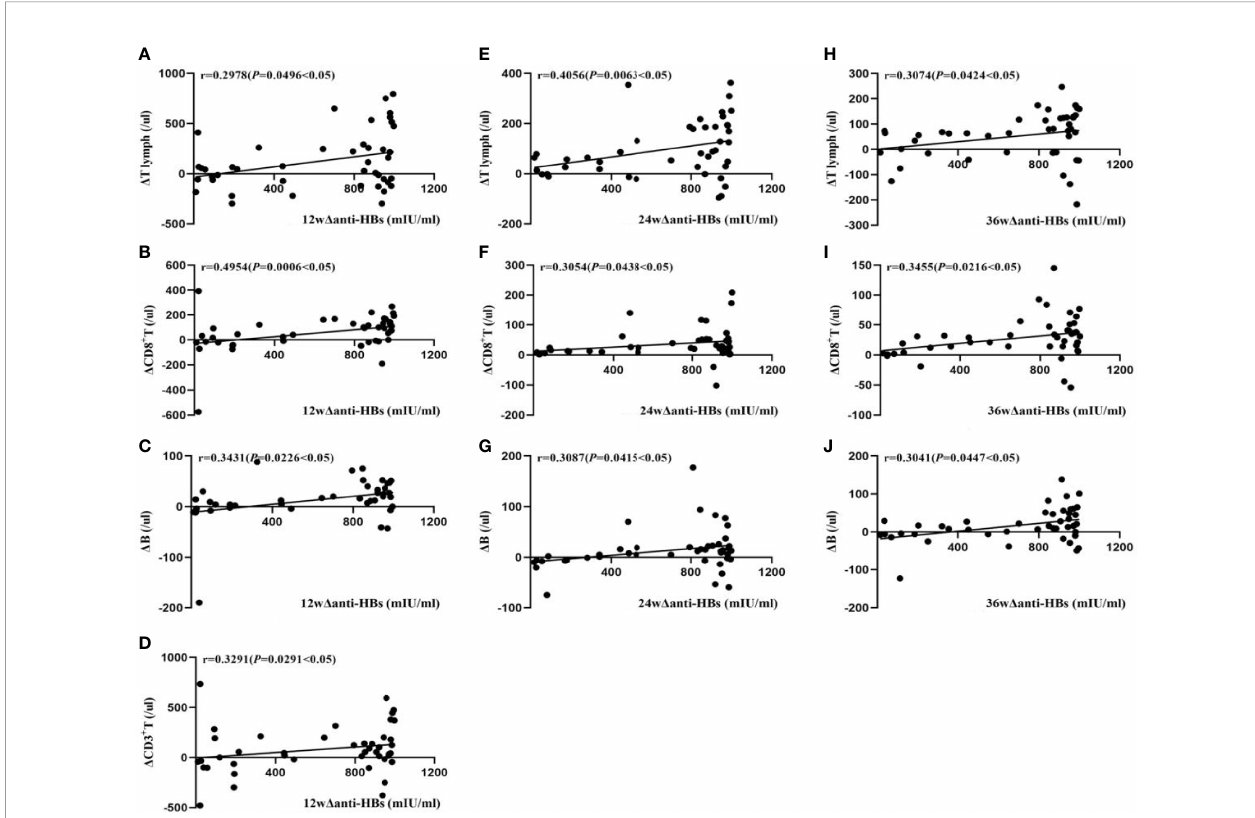
FIGURE 1 | Correlation analysis of D anti-HBs and D immune cells in Group A at week 12 (A – D) , week 24 (E – G) , week 36 (H – J) .